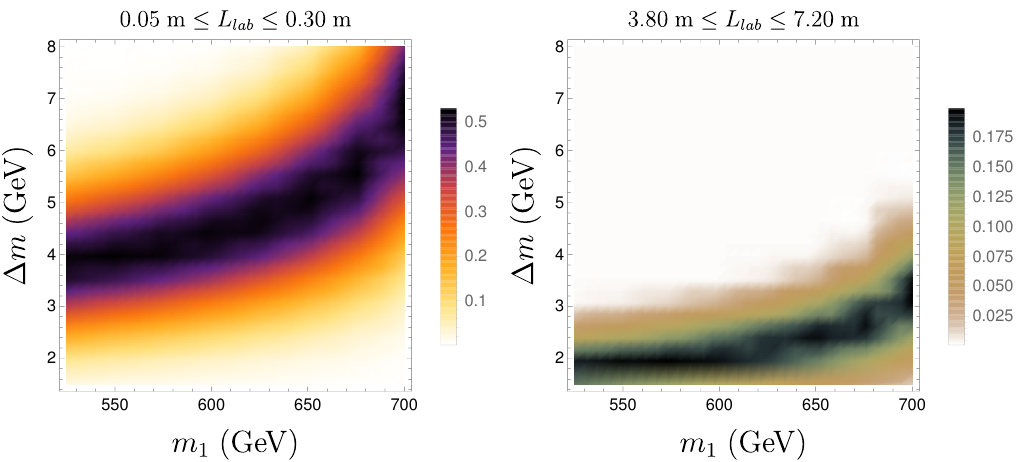
Figure 3 . Probability that (cid:31) solenoid (right panel), for M Z 0 = 1 : 5 TeV and k =